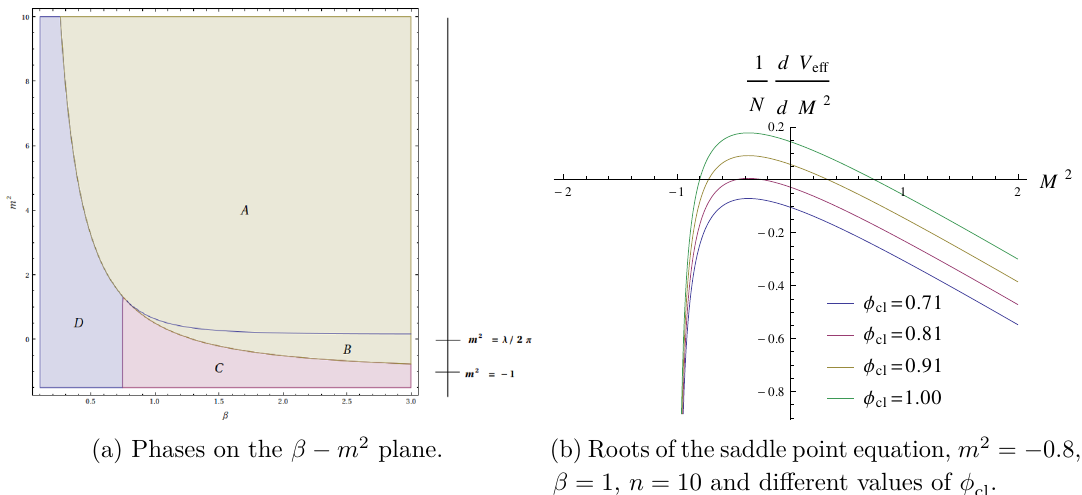
Figure 5. Phases and roots of saddle point equation for AdS 3 with negative renormalized